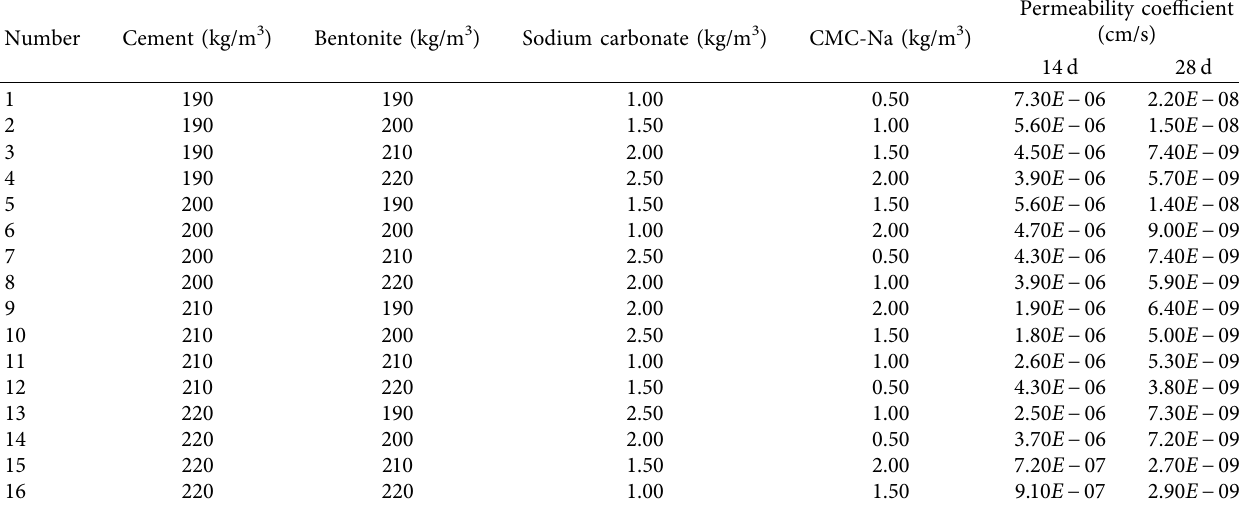
Table 2: Orthogonal experimental